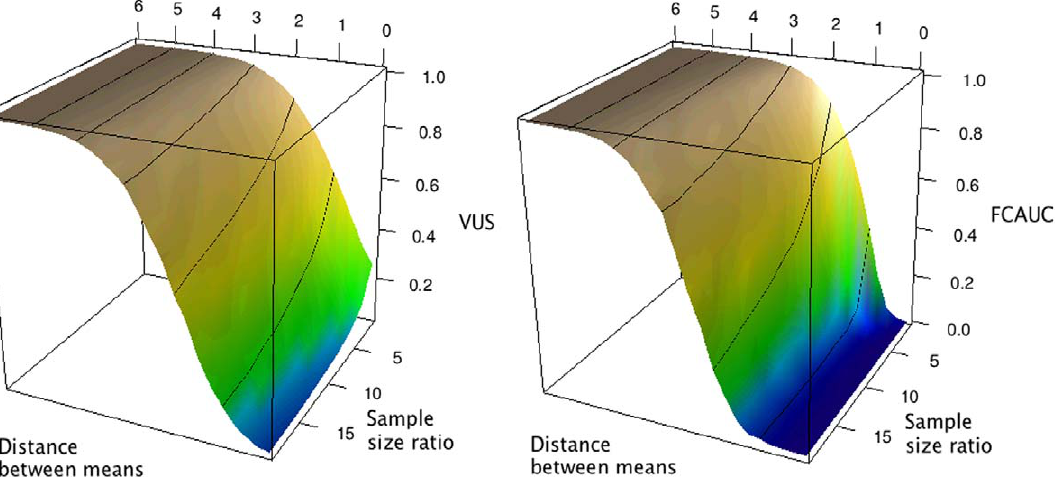
Figure 3. Simulation results – average VUS and FCAUC values as functions of the distance between the mean of the true negative and true positive distributions and the class ratio ( # negative/ # positive). The two distributions are both normal with standard deviation one. Black curves: values corresponding to integer distances between means.